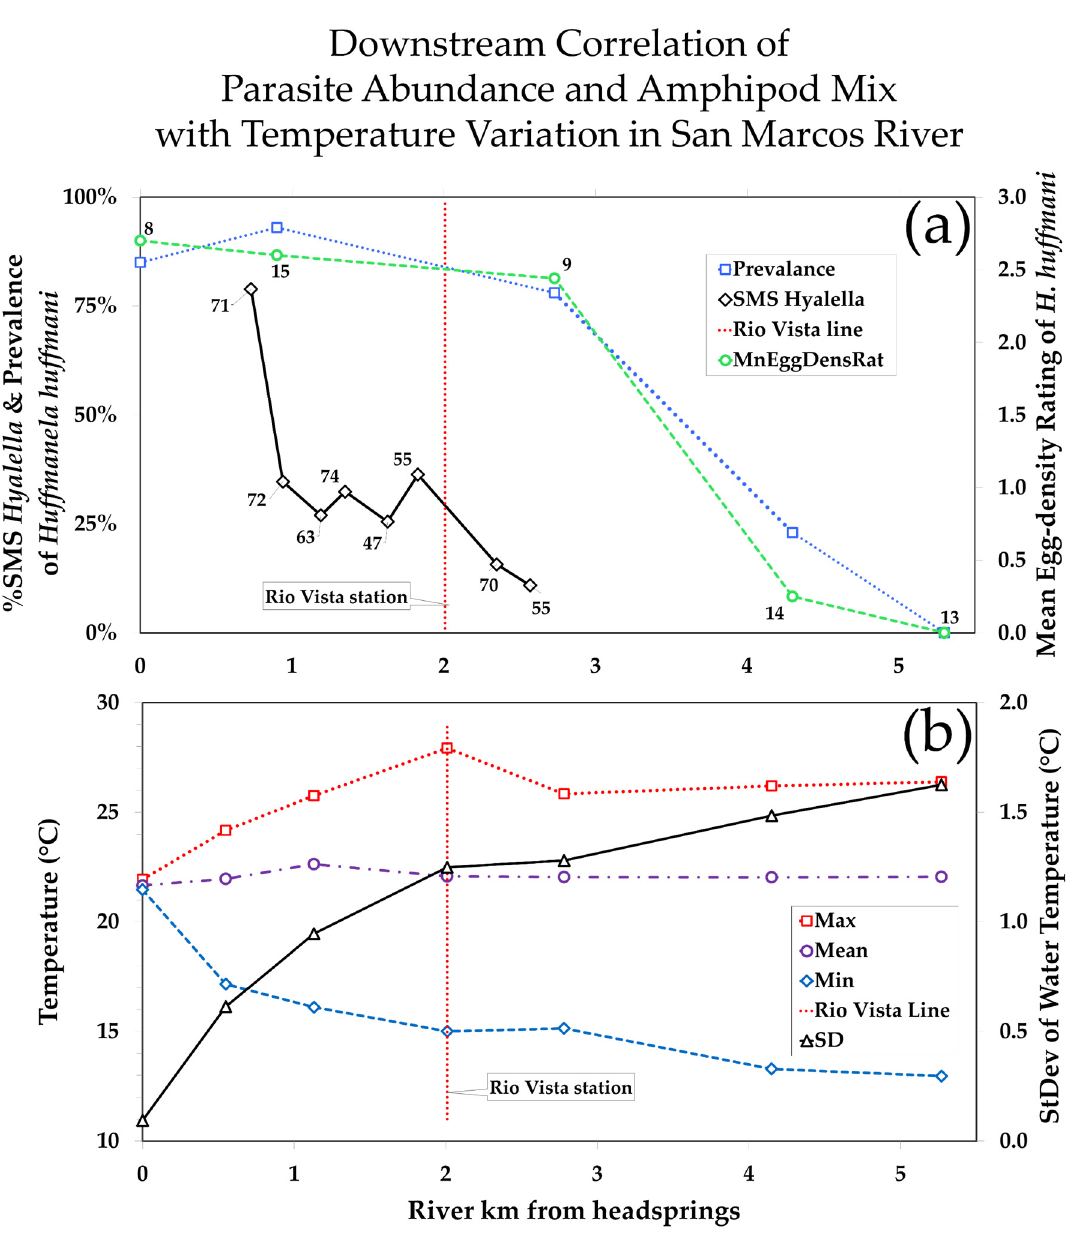
Figure 4. ( a ) Variation in prevalence and mean egg‑density ratings for Huffmanela huffmani in wild‑ caught centrarchids, and %relative abundance of amphipods sampled that were SMS Hyalella —all plotted against river kilometers down‑stream from the headsprings of the San Marcos River; data labels are sample sizes. ( b ) Variation in mean temperature and standard deviation of temperature at various stations downstream from headsprings along with 14 y minima and maxima. All temper‑ ature data were recorded at 4 h intervals during years 2000–2014, which included years of severe drought followed by